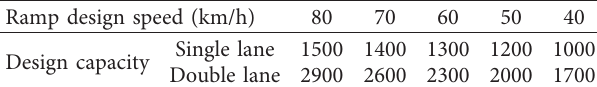
Table 1: Ramp design capacity of basic